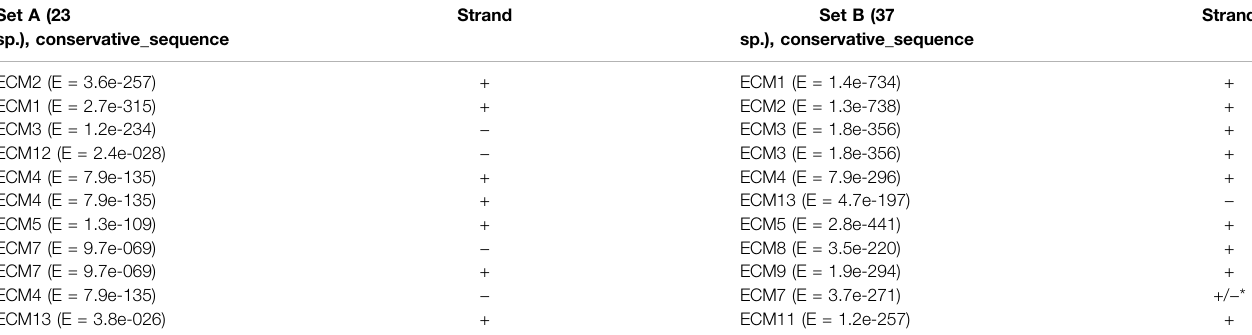
TABLE 1 | Homology of evolutionarily conserved motifs isolated from the Set A (37 species) and the Set B (23 species) of the ras85D promoter region sequences. Set A (23 sp.), conservative_sequence